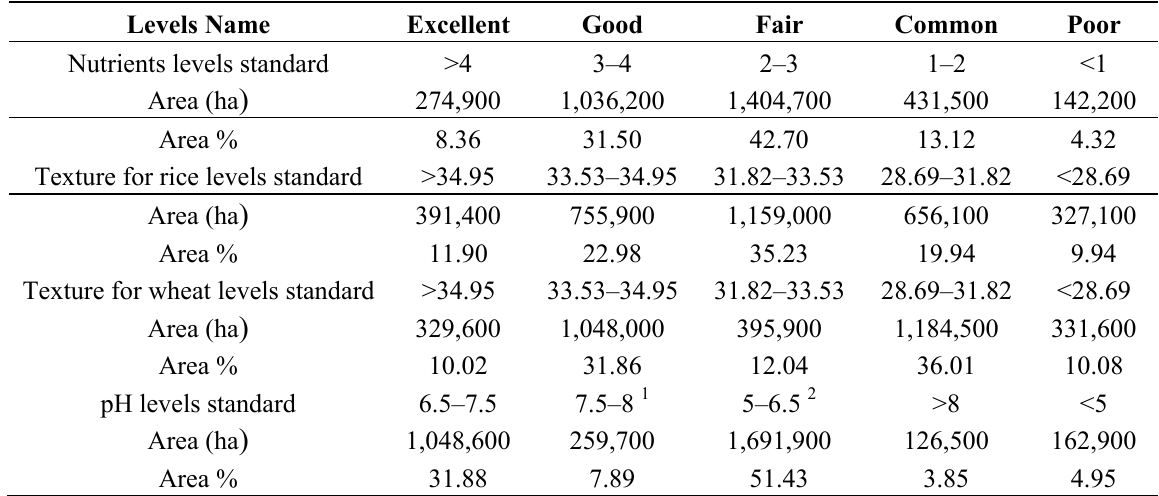
Table 4. Soil fertility levels